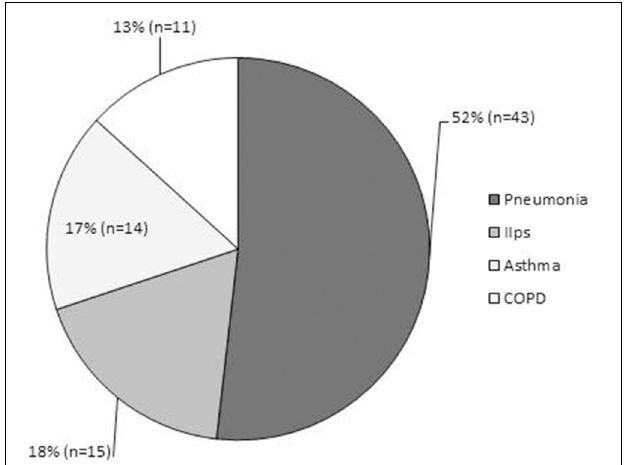
FIGURE 7 | Epidemiological data of adult patients admitted throughout the year to Kyorin University Hospital for respiratory disease. Diagnoses consisted of acute exacerbation of idiopathic interstitial pneumonias ( n = 15, 18%); pneumonia ( n = 43, 52%), including 4 cases of definite Mp pneumonia diagnosed by CF antibody titer of ≥ four-fold or passive particle agglutination test ≥ 640; asthma attack ( n = 14, 17%); and exacerbation of COPD ( n = 11,